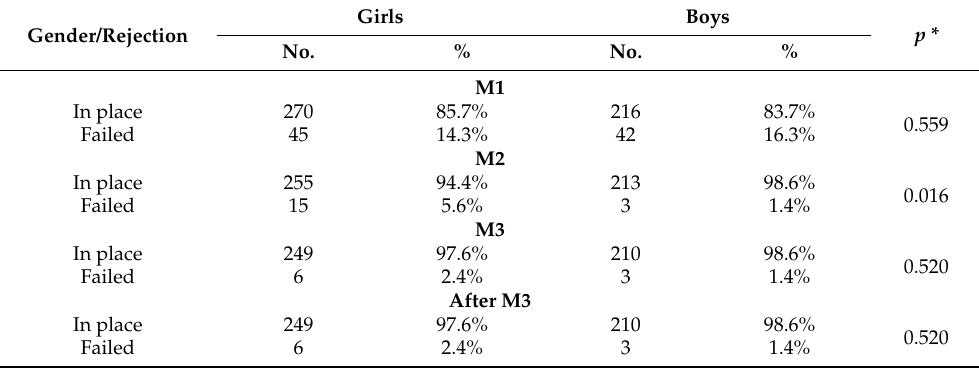
Table 4. Distribution of the mini-implants according to gender and the rejection rate in M1, M2, M3 and after